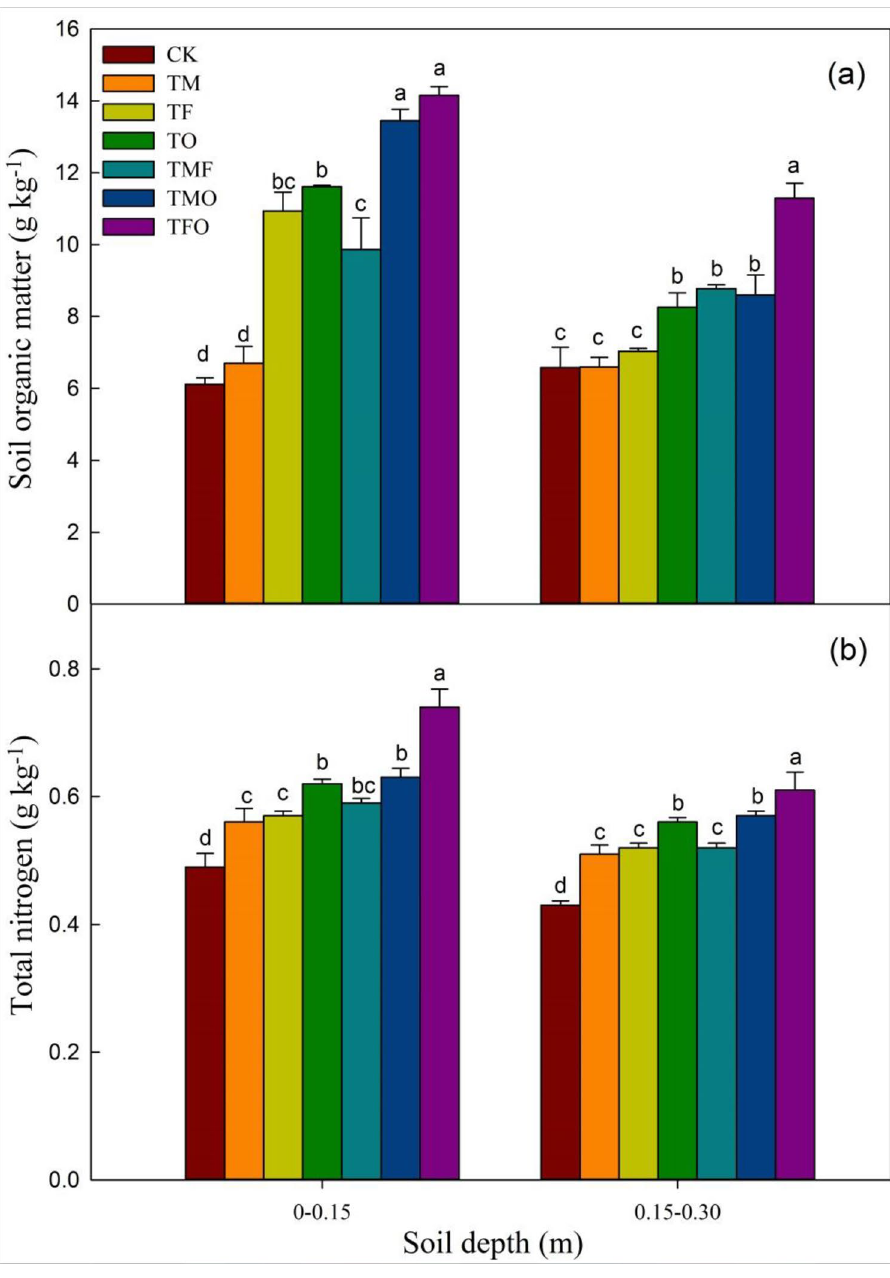
Figure 1. Effects of the application of different improved materials on SOM and TN CK: no improved material; TM: maturing agent (ferrous sulfate); TF: fly ash; TO: organic fertilize; TMF: maturing agent + fly ash, TMO: maturing agent + organic fertilizer; TFO: fly ash + organic fertilizer; SOM, soil organic matter; TN, total nitrogen. Different lowercase letters represent significant differences among different improved material treatments in the same soil